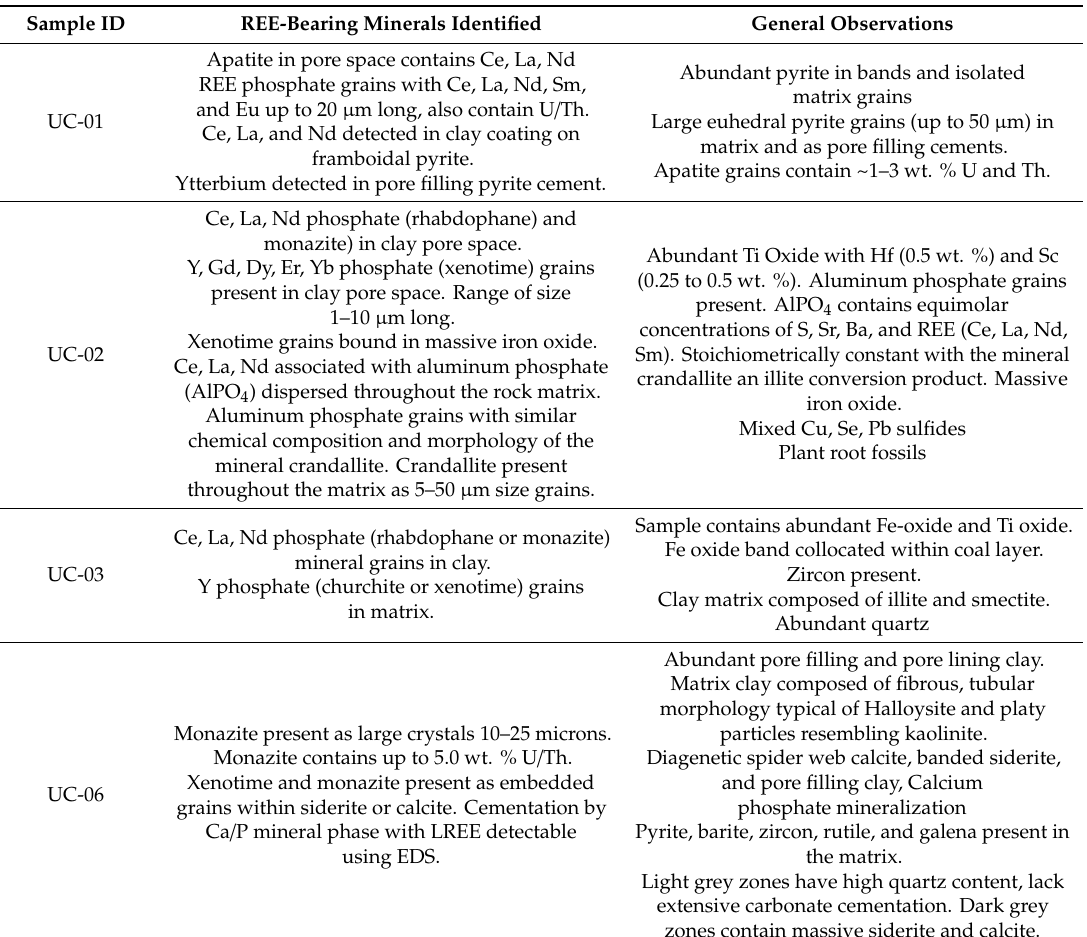
Table 6. General characterization results from SEM-EDS